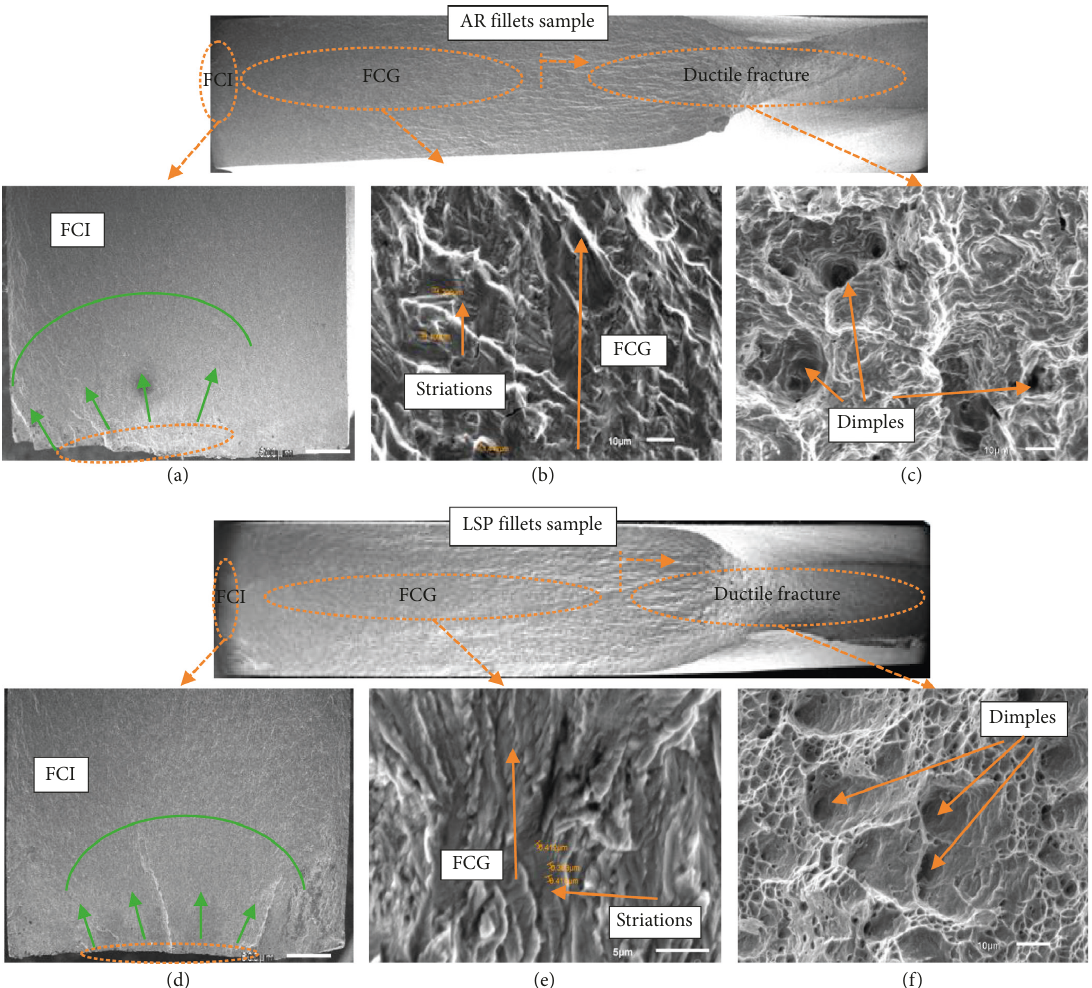
Figure 14: Fracture surfaces of the specimens with filet: (a, d) crack initiation, (b, e) fatigue crack growth, and (c, f) final